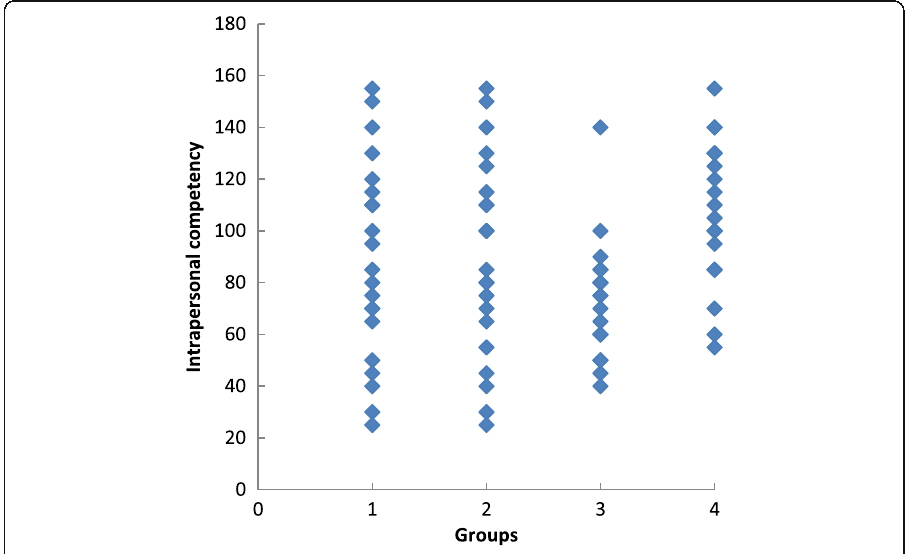
Fig. 2 Intrapersonal competency across